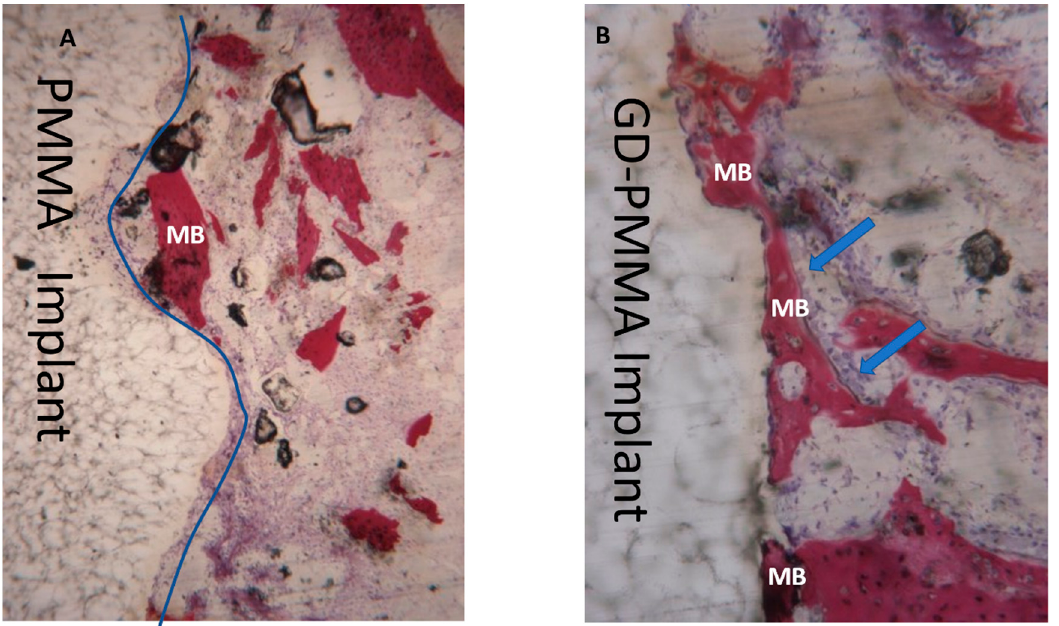
Figure 3. ( A ) PMMA implant. Mature bone (MB) in direct contact with the implant (blue line) is present. Acid fuchsin- toluidine blue 100X. ( B ) GD-PMMA implant. Mature bone (MB) in direct contact with the implant and osteoblast activity (arrows). No degradation layers or cracks and detachment of fragments are observed in either implant. Acid fuchsin- toluidine blue 100X.